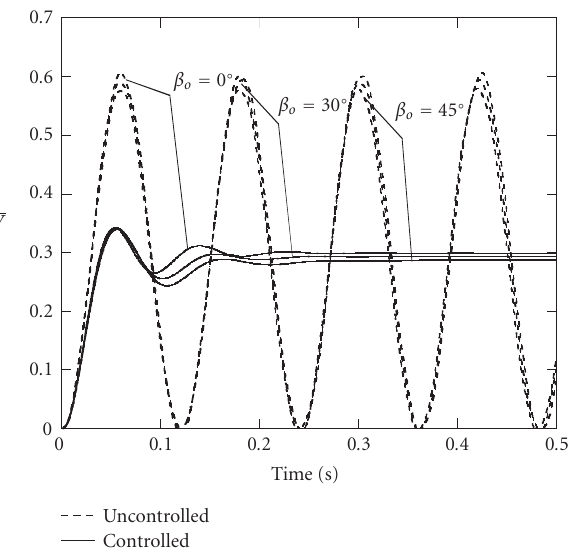
Figure 19: Influence of the pretwisted angle on the uncontrolled/ controlled flapping nondimensional deflection time-history of the nonrotating blade subjected to a step pulse with σ = 1, γ = 0deg, Ω = 0rad/s, and θ = 45deg.